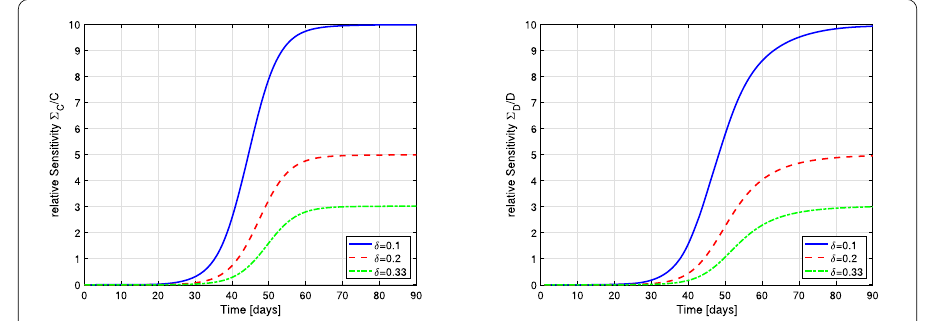
Figure 4 Relative sensitivities of C (left) and D (right) with respect to the detection rate δ for δ = 0.1 (blue solid), δ = 0.2 (red dashed) and δ = 0.33 (green dash-dotted). At the onset of the epidemics, the sensitivities are extremely small, hence no reliable identification of δ is possible